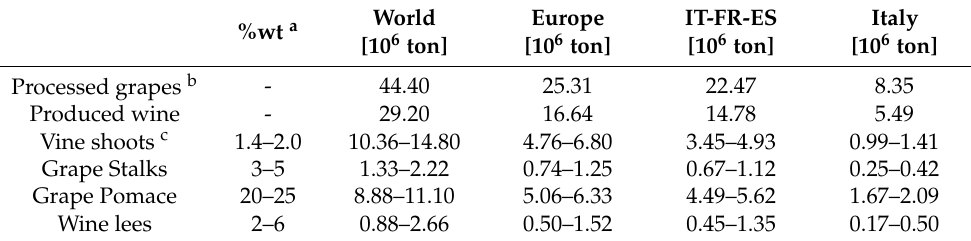
Figure 1. Scheme of the winemaking processes and associated solid wine wastes. Table 2. Production data of grapes, wine, and solid by-products in